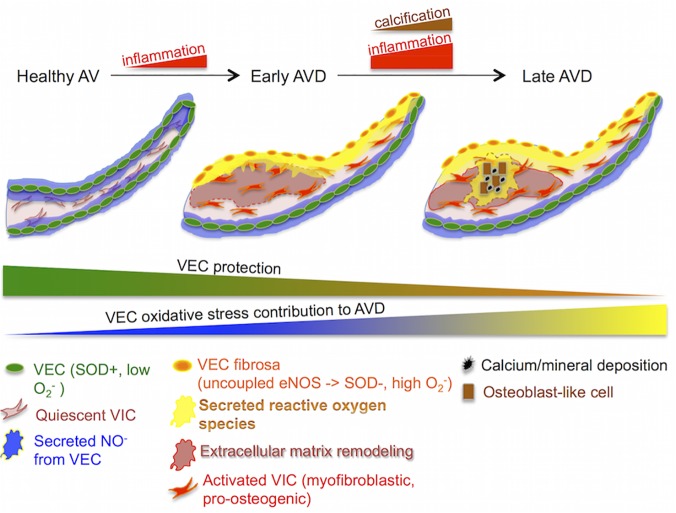
Valve endothelial oxidative stress contributes directly to aortic valve disease.In a healthy valve, endothelial cells secrete protective NO, maintaining quiescence of valve interstitial cells. Early AVD is characterized by inflammation-driven side specific increase in VEC oxidative stress, in part via eNOS uncoupling, causing disorganization of the extracellular matrix and loss of protective NO secretion in the fibrosa. In late AVD, oxidative stress from VEC contributes to calcification and mineral deposition, while NO and SOD are decreased in fibrosa VEC.